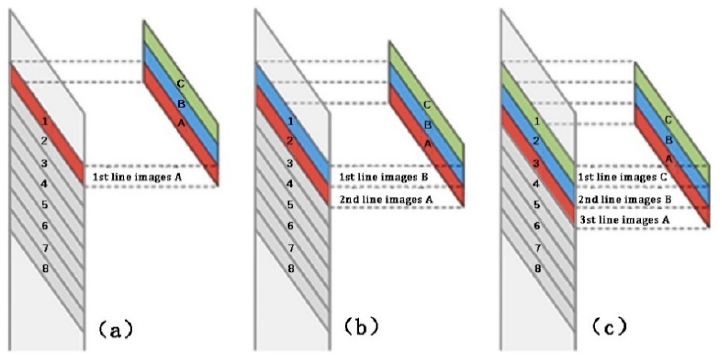
Figure 4. Integral imaging principle. ( a ) is the first line of the sensor in a certain spectral band to image object A; ( b ) is with the movement of the satellite, the first line is to image object B, and the second line is to image object A; ( c ) is the image of object A with the movement of the satellite. For the movement of the satellite, the first line images object C, the second line images object B, and the third line images object A, and so on, to achieve eight integral images of the same scene in each line.